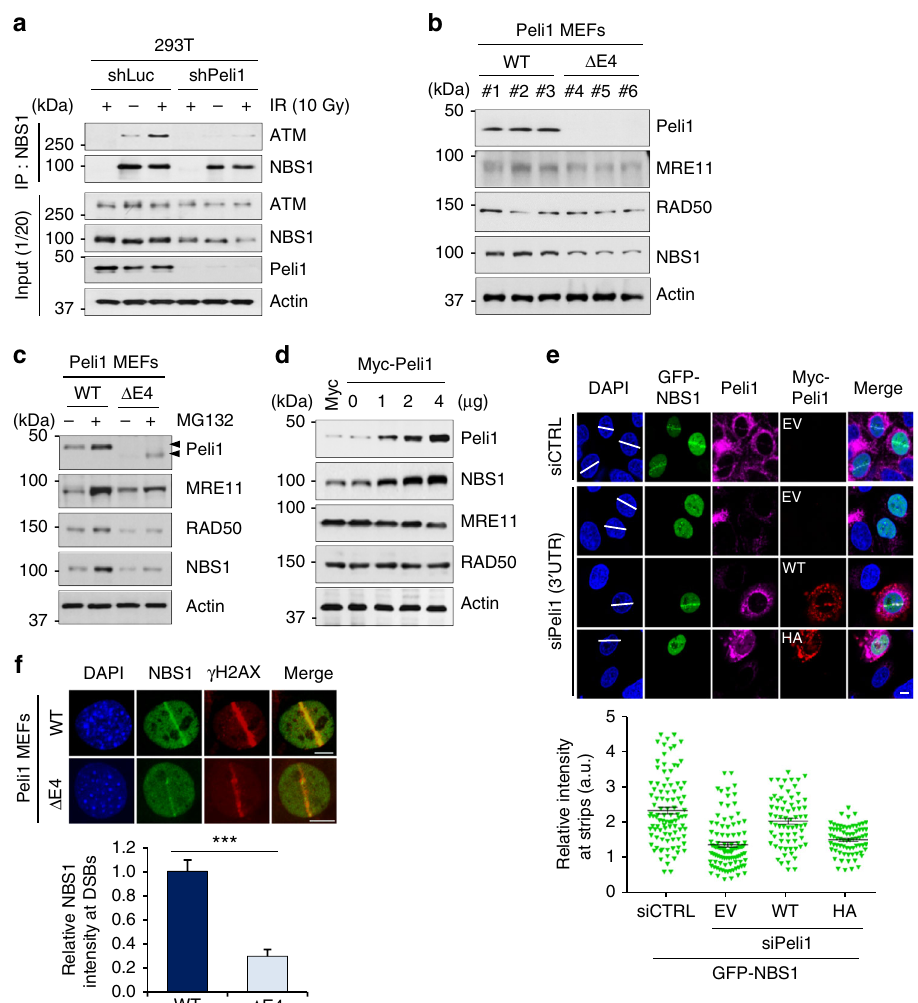
Fig. 8 Peli1-mediated NBS1 ubiquitination stabilizes the Mre11, RAD50, and NBS1 (MRN) complex. a 293T cells were transfected with shLuc or Peli1 and treated with or without IR (10 Gy). At 30 min post-IR, cells were collected and immunoprecipitated with an anti-NBS1 antibody. NBS1 protein complexes were subjected to immunoblotting. b Immunoblotting of MRN complex components in Peli1 WT and E4 truncated MEF cells using antibodies indicated. c Peli1 WT and E4 truncated MEF cells were treated with proteasome inhibitor MG132 (10 μ M) for 6 h. Cells were subsequently subjected to immunoblotting. d 293T cells were transfected with Myc-Peli1 expression plasmid. At 48 h post transfection, cells were collected and cell lysates were analyzed by immunoblotting with antibodies indicated. e siRNA-targeting control (CTRL) or endogenous Peli1 (3 ′ -UTR) was transfected into U2OS cells in combination with GFP-NBS1. U2OS cells reintroduced with empty vector (EV), Myc-Peli1 WT, or RING mutant (HA) were subjected to micro-irradiation at 48 h. At 30 min post micro-irradiation, cells were fi xed and immunostained with anti-Peli1 and anti-Myc antibodies. The intensity of GFP-NBS1 at laser stripes was determined by averaging values from 10 to 20 cells and graphed. Scale bars, 10 μ m. f Peli1 WT and E4 truncated MEF cells were micro- irradiated with a UV laser, fi xed after 10 min, and immunostained with anti-NBS1 and anti- γ H2AX antibodies (upper panel). Scale bar, 10 μ M. Mean levels of NBS1 accumulation at sites of laser tracks were quanti fi ed (lower panel). Student ’ s t -test was used for statistical